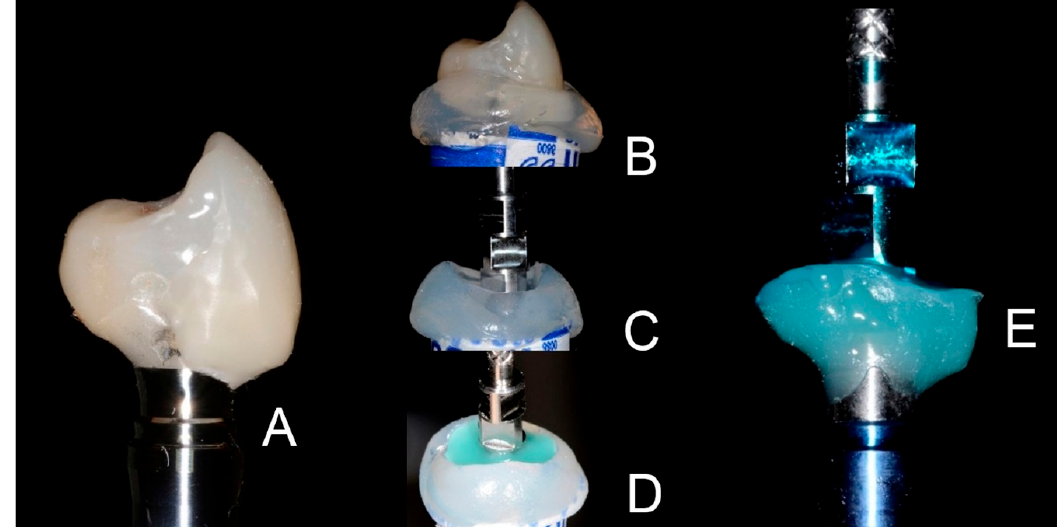
Figure 1. The individual transfer technique consists of replicating the same emergence profile of the provisional crown on the transfer, so as not to induce any further tissue adaptation to the prosthetic margins. The provisional is connected to an analogue ( A ), a silicon impression (Aquasil®, Dentsply Sirona, York, PN, USA) of the assembly is performed ( B ) and, after disconnecting the provisional, a transfer is set in place connected to the analogue sitting in the silicone ( C ). In the gap between the silicon and the transfer some flowable composite is light-cured ( D ). The transfer reproduces the same emergence as the provisional ( E ).